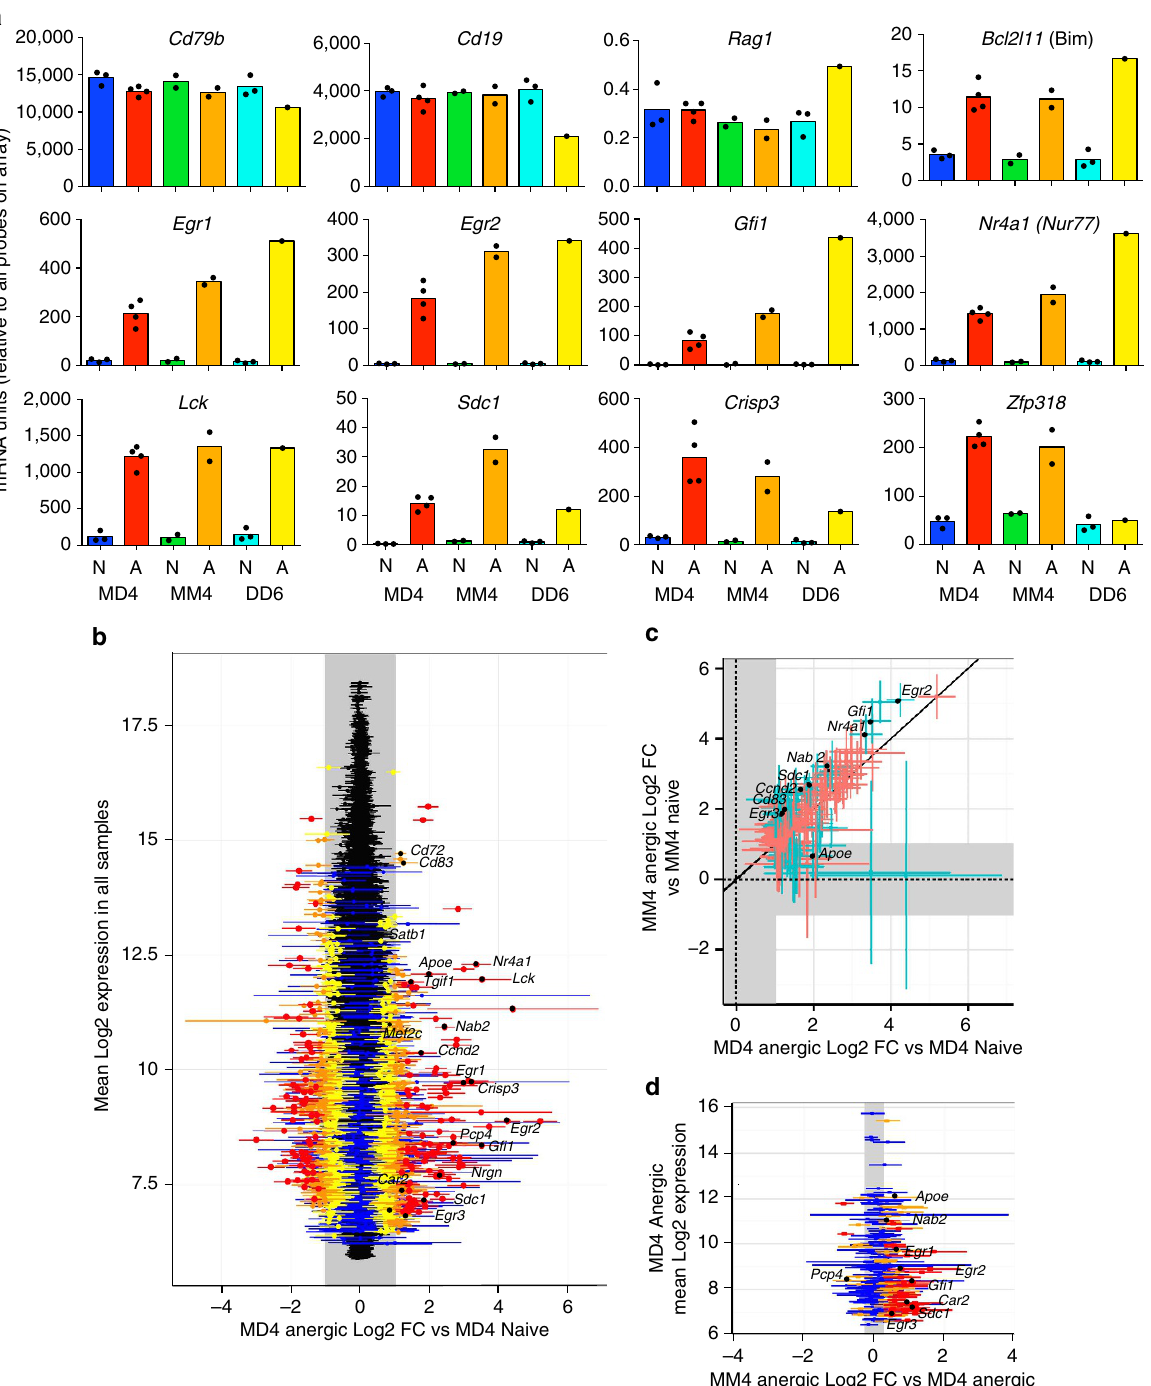
Figure 4 | Impact of IgD-deficiency on the anergic B cell gene expression program. Naı¨ve (N) or anergic (A) HEL-binding CD93 (cid:2) CD23 þ mature spleen B cells were sorted from individual MD4 or MD4:ML5 (co-expressing IgM HEL and IgD HEL ), MM4 or MM4:ML5 (only expressing IgM HEL ), and DD6 or DD6:ML5 (only expressing IgD HEL ) transgenic mice, and mRNA analysed on Agilent microarrays. ( a ) Analysis by Agilent feature extraction software. Dots show values and columns arithmetic means for indicated mRNA probes from independent mice per genotype, except DD6:ML5 where RNA was pooled from three sorted donors. ( b – d ) Analysis by limma. ( b ) Y -axis, mean expression in all samples for 33,653 mRNA probes with positive expression in anergic B cells. X -axis, mean and 95% confidence interval (CI) for Z 2-fold change (FC, grey shaded region) in MD4:ML5 anergic cells relative to MD4 naı¨ve cells: red, strong evidence; orange, moderate evidence; yellow, weak evidence; blue, very weak; black, no evidence. Black squares and gene symbols show mean FC for previously identified anergy-induced mRNAs. ( c ) 220 probes with strong or moderate evidence of Z 2-fold increase in MD4:ML5 anergic cells. X -axis as in ( b ). Y -axis, mean and 95% CI of Z 2 FC in expression in MM4:ML5 anergic cells relative to MM4 naı¨ve cells. ( d ) 220 anergy-induced probes in ( c ), showing mean and 95% CI of Z 1.25 FC in MM4:ML5 anergic cells without IgD relative to MD4:ML5 anergic cells with IgD. Black squares and accompanying gene symbols are previously identified anergy-induced mRNAs with differential expression in IgD-deficient anergic